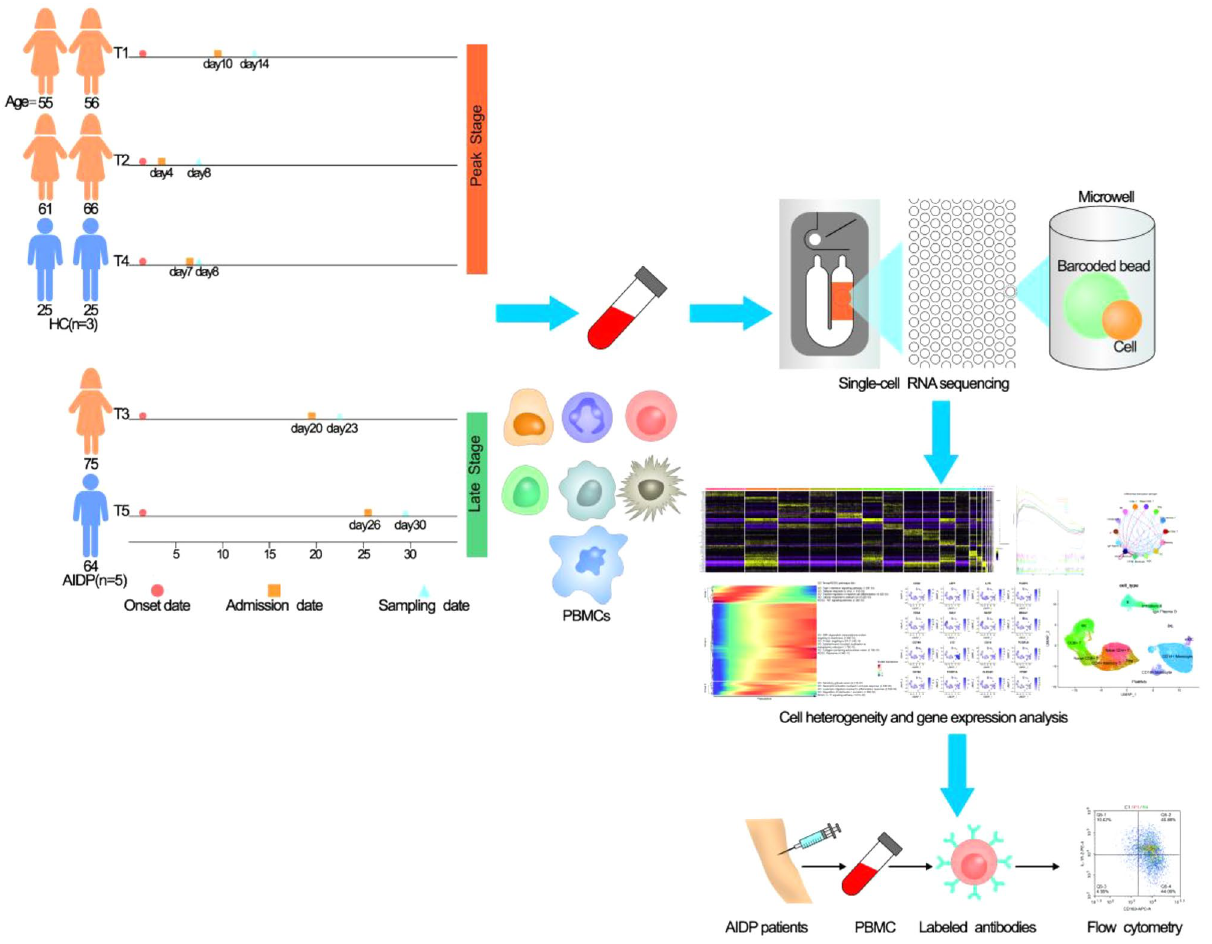
Figure 1. A schematic diagram of the experimental workflow and clinical information of the